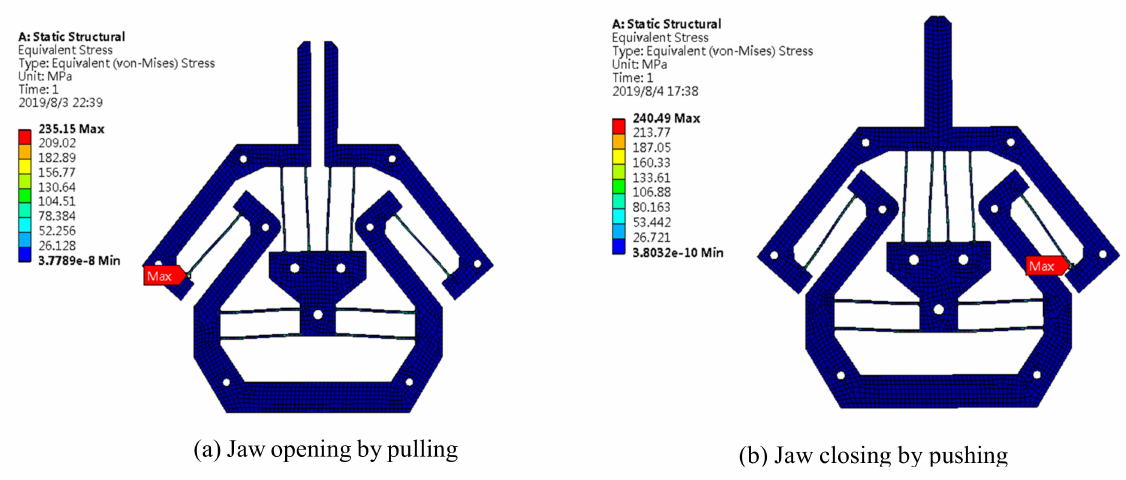
Figure 7. Simulation